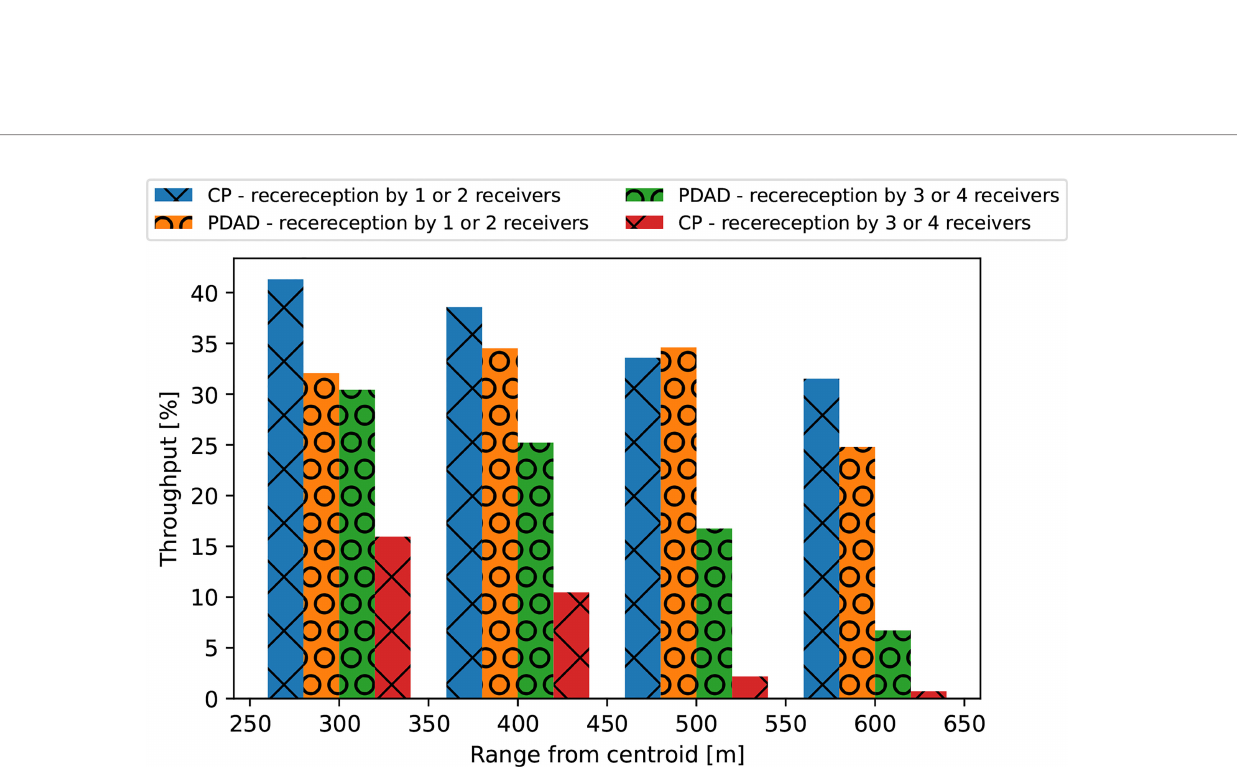
FIGURE 9 | x 2,r ratio between emissions received by one or two receivers and the total number of acoustic emissions (CP - blue, PDAD - orange), and x 3 ,r - ratio between localized tags to the total number of acoustic emissions (CP - red, PDAD - green). For the PDAD method, the throughput of localized emissions is better than the CP as the range increases, i.e., more emissions are localized at larger ranges for the PDAD method, leading to a larger usable